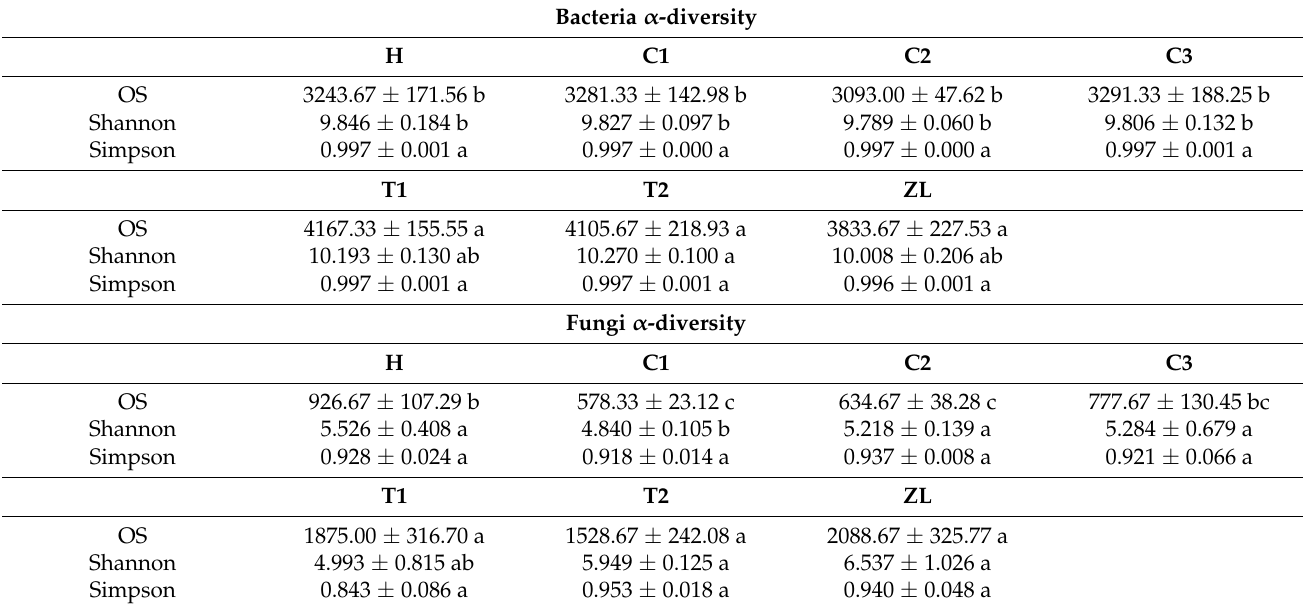
Table 4. Alpha-diversity, including observed-species, Shannon and Simpson indices of the soil bacterial and fungal community in the Carex marsh sampling